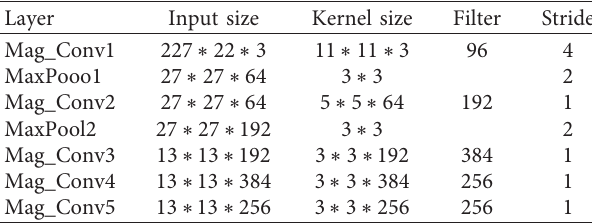
Table 1: The network of Mag_Conv1-5.